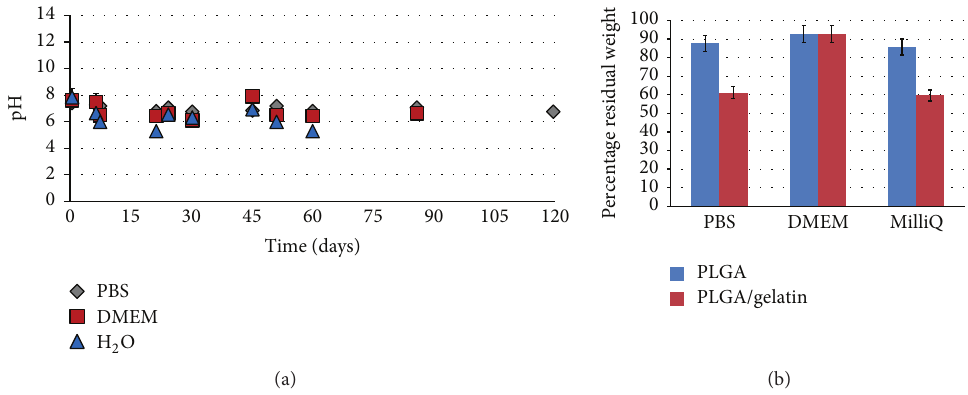
Figure 5: pH measurements in three different means of incubation (PBS, DMEM, and MilliQ water) for the sample microstructured PLGA/gel 70/30 at various incubation times up to 120 days (a); percentage residual weight for a microstructured PLGA/gel 70/30 sample and a microstructured PLGA pure sample, measured in PBS, DMEM, and MilliQ water after 7 days